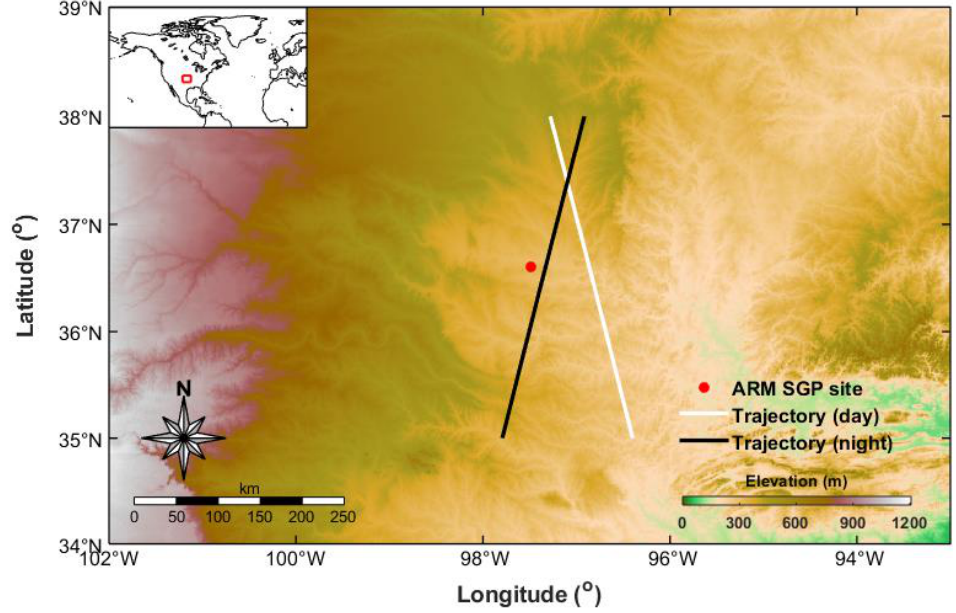
Figure 1. Location of the Southern Great Plains (SGP) central facility site. The white and black lines refer to the CALIPSO trajectory in the daytime and nighttime, respectively.